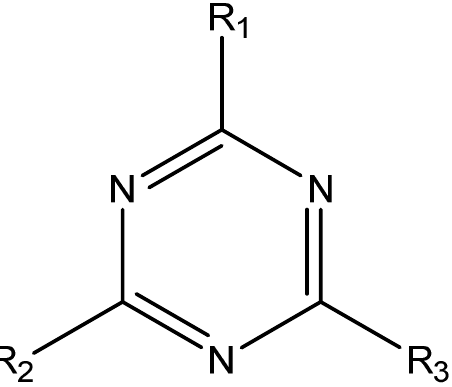
Figure 3. General structural formula of triazine herbicides.